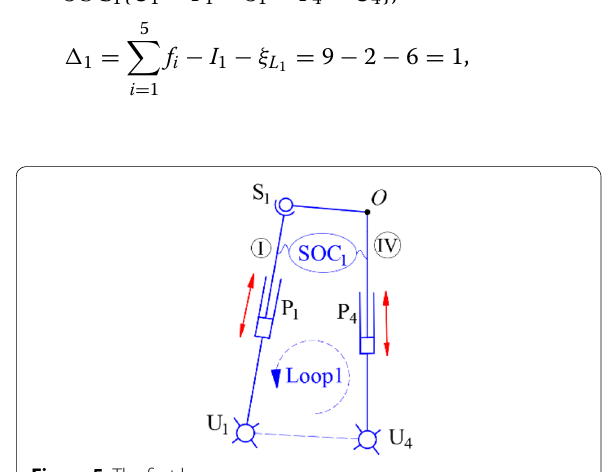
Figure 5 The first